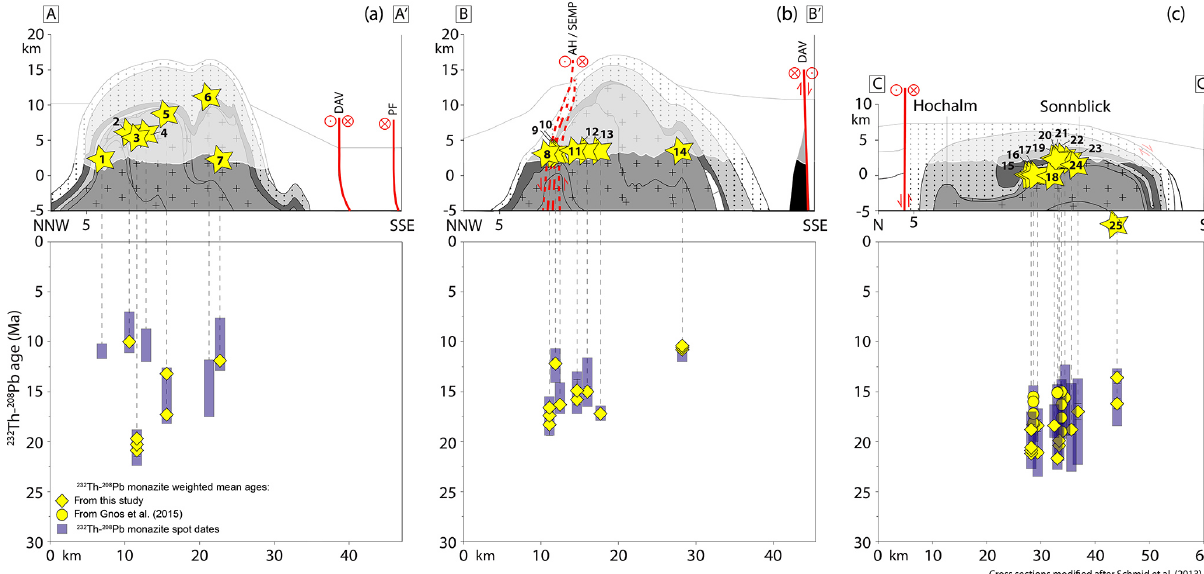
Figure 6. Cross sections of (a) the western part of the western subdome, (b) the central part of the western subdome and (c) the western end of the eastern subdome, modified after (Schmid et al., 2013). See Fig. 1 for locations and legend. Sample locations are indicated by yellow stars and identified by sample numbers listed in Table 1. Monazite crystallization ages are present in the lower part of the figure and are linked to each sample by light-grey dashed lines. Weighted mean ages from this study and from Gnos et al. (2015) are presented by yellow diamonds and yellow circles, respectively, and blue bars correspond to the range of single spot